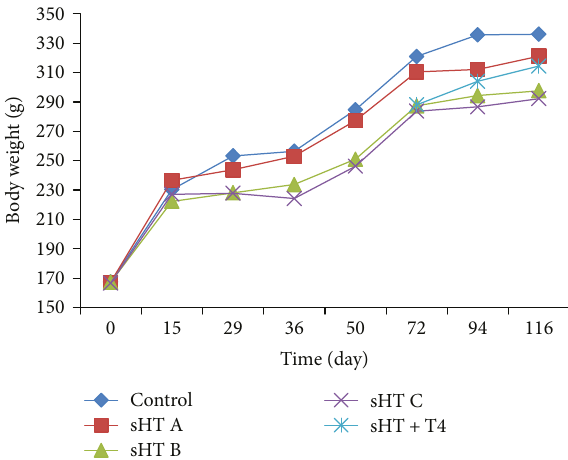
Figure 1: sHT rats experienced a stunted growth pattern and L-T4 treatment improved the body weights of sHT